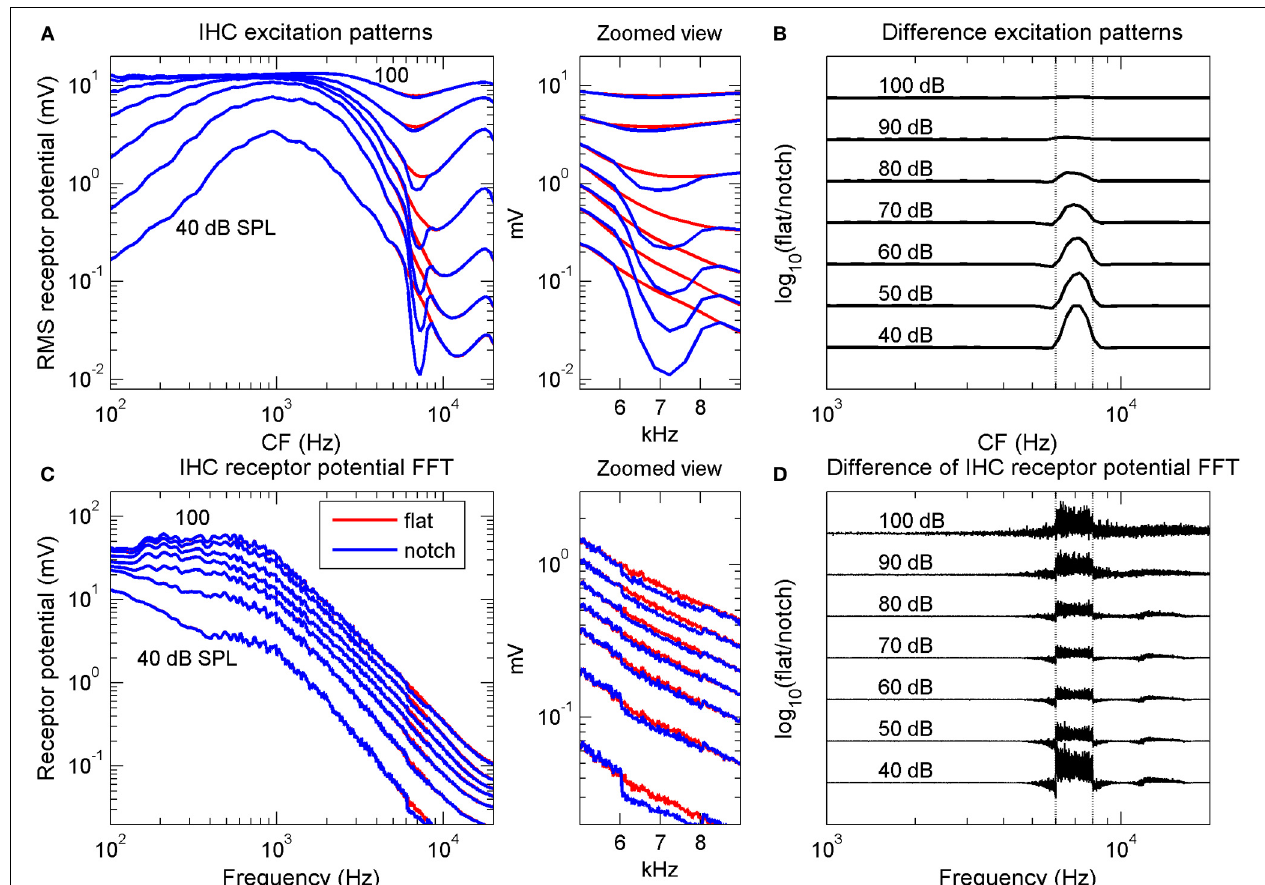
FIGURE 2 | Computational simulation of inner hair cell receptor potentials. Simulated IHC responses to broadband noises with a flat spectrum and with a 2-kHz wide, 15-dB spectral notch centered at 7kHz. The noise duration was longer than that used in the psychoacoustical experiments (0.5 vs. 0.2s) to obtain “smoother” responses. (A) IHC excitation pattern representation of the flat-spectrum (red) and notch noises (blue). Each curve illustrates the average (rms) receptor potential of each IHC as a function of the cell’s CF, for a different stimulus level, from 40 to 100dB SPL, as indicated by the numbers next to each trace. (B) Difference excitation patterns (in dB) normalized to the maximum value